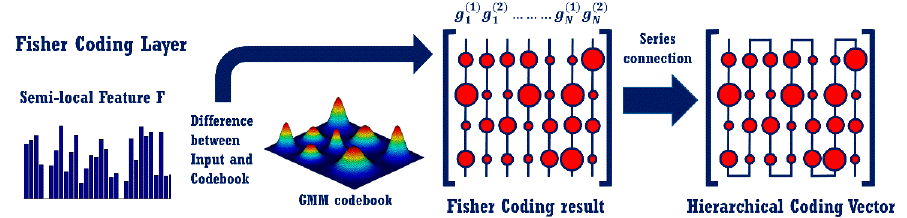
Figure 3. The pipeline of the Fisher coding layer.